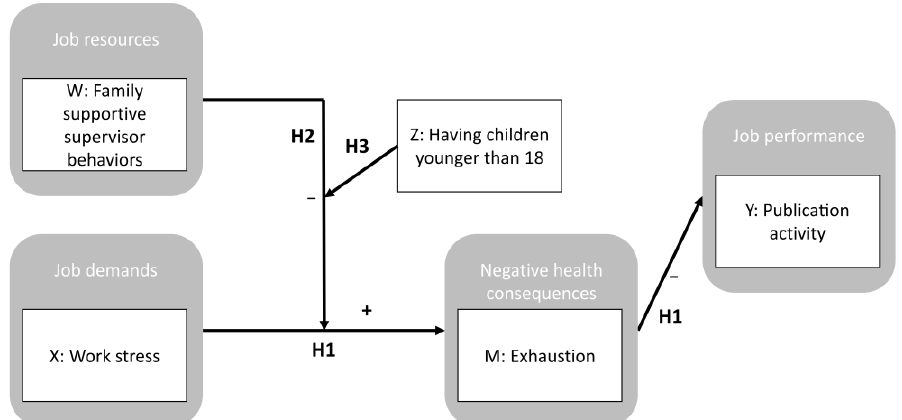
Figure 1. Part of the Job Demands – Resources Model Considered in the Current Study. Based on the Job Demands – Resources Model, it was tested whether work stress (X) would be associated with feelings of exhaustion (M) and, consequently, be linked to academic employees’ publication activity (Y; H1). Family supportive supervisor behaviors (W) were tested as a moderator of the association between work stress and feelings of exhaustion (H2). Finally, it was tested whether family supportive supervisor behaviors would moderate the association between work stress and feelings of exhaustion, especially in employees with children younger than 18 (Z; H3). Arrows represent associations between variables. Higher scores in one variable were expected to go along with higher scores in another variable (“+”) or with a lower score in another variable (“−“).